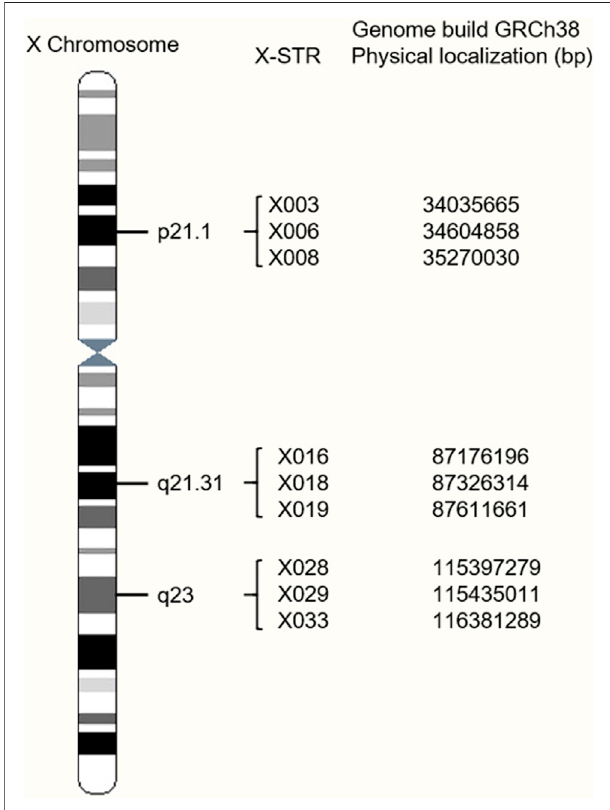
FIGURE 1 | Location of the nine X-chromosomal short tandem repeats (X-STR) loci on an X-chromosome ideogram.